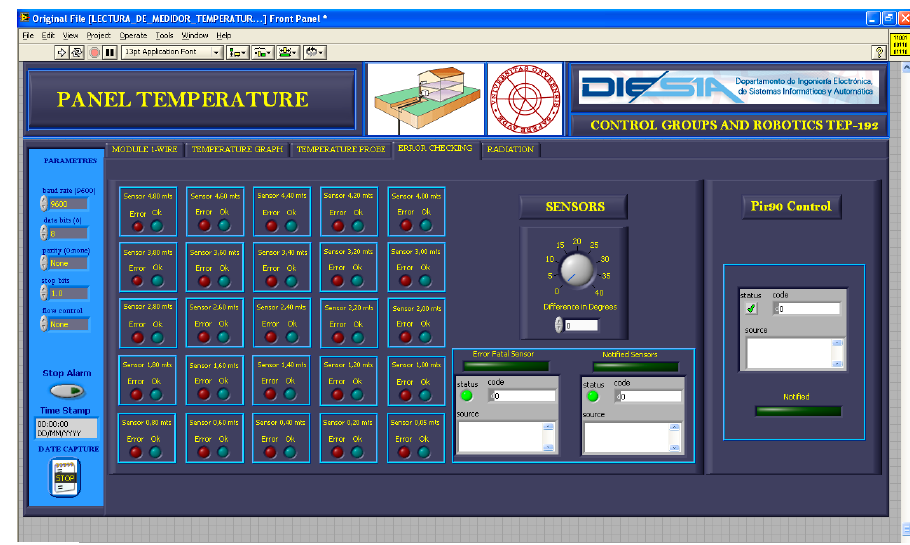
Figure 8. Screen that show faults in any TS of the GTP and allows adjustment of all parameters.